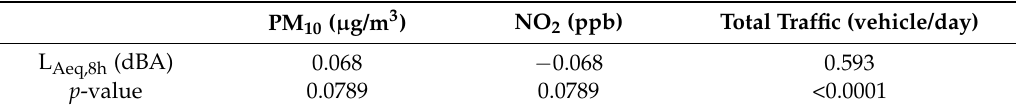
Table 3. Spearman’s correlations between noise, air pollutants, and traffic in subjects.